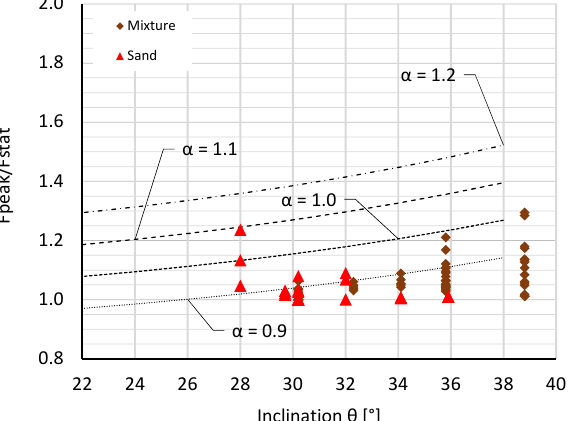
Figure 17. Relation of F peak / F stat as a function of the dynamic pressure coefficient and the inclination of the flume base ( θ ). For a constant factor α , a higher inclination angle ( θ ) results in a higher ratio of F peak / F stat .